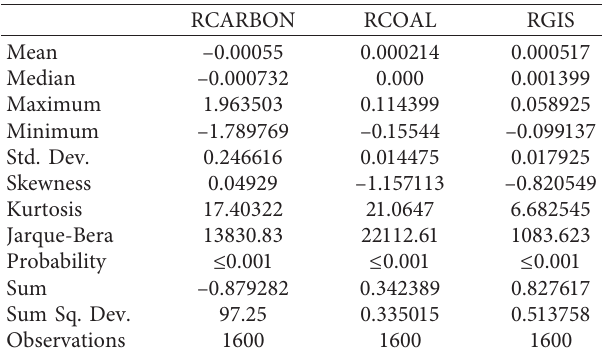
Table 3: Descriptive